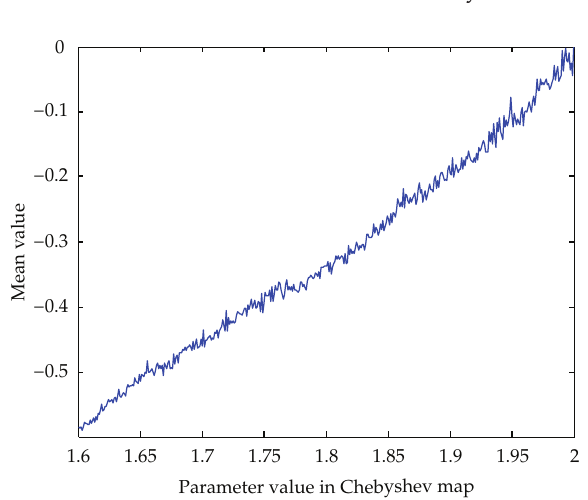
Figure 2: Mean value estimation M (cid:2) θ (cid:3) of chaotic sequence generated by Chebyshev map with di ff erent parameters (cid:2) parameter sampling length is 0.001 (cid:3) .